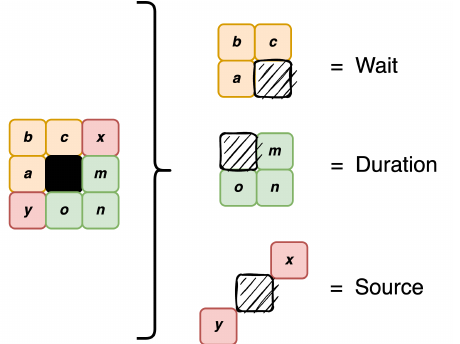
Figure 25. Coding scheme for the two-dimensional PQCA.